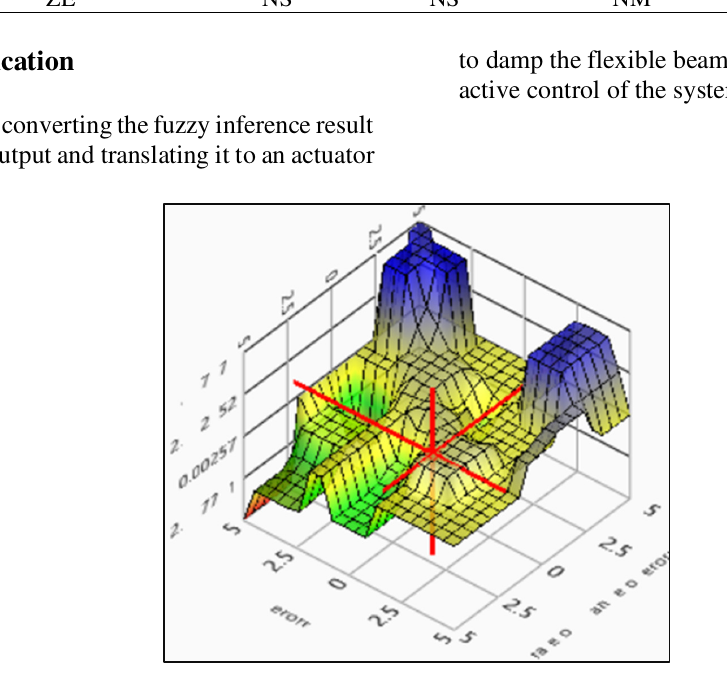
Fig. 4. Viewed surface of input/output